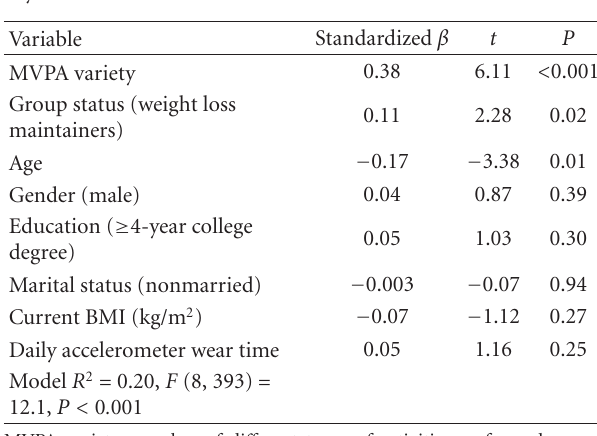
Table 2: Associations of physical activity variety and group status with moderate-to-vigorous physical activity (MVPA) minutes per day.